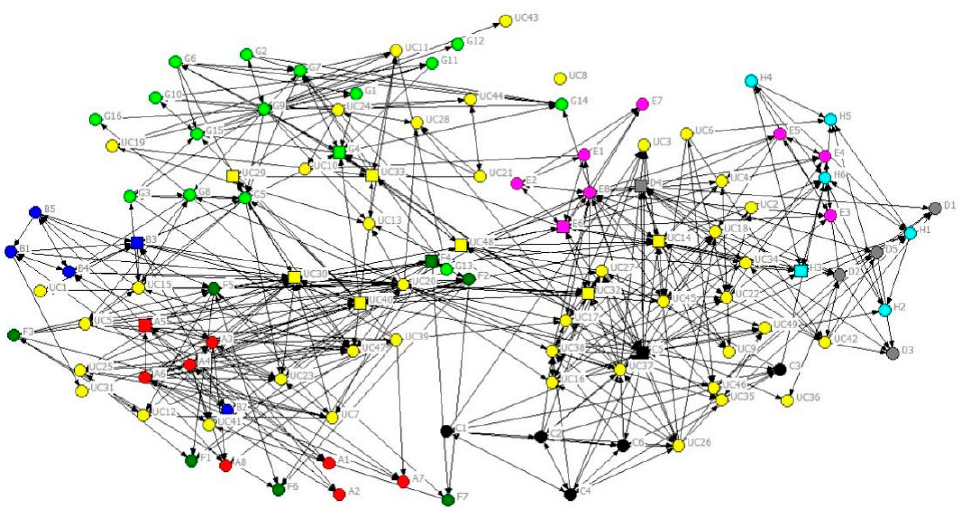
Figure 3. Phase 1 sociogram for preferred idea sharing (strength of tie = 3). *Same organisation and key contact attribute display in Figure 2.